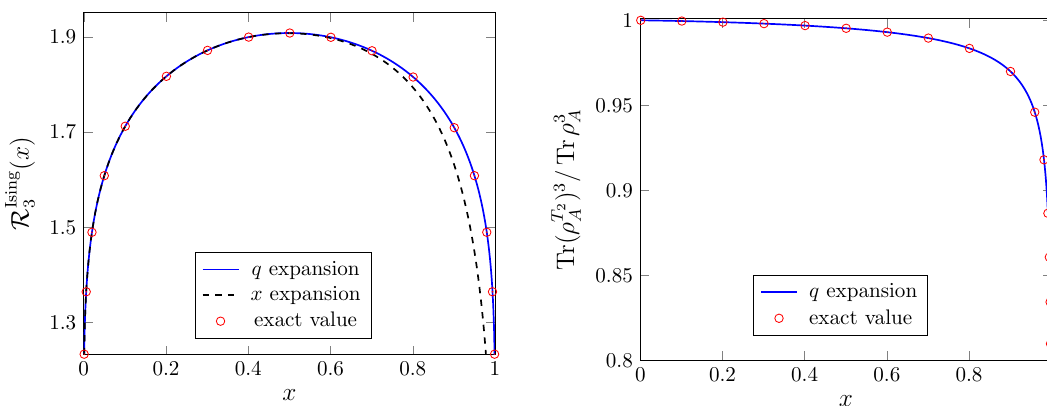
and Tr ( ρ T 2 ) N for N = 3 in the free Majorana fermion Figure 2 . Analysis of the moments Tr ρ N A A (Ising CFT). In the left panel, we consider the function R ( x ) defined in eq. (5.14). The dots 3 correspond to the exact values calculated using eq. (E.7). The continuous line has been obtained by approximating, in eq. (5.14), Tr ρ 3 with its expansion in sphere conformal blocks, see eq. (5.6) A and appendix E, truncated at level L = 6 . The dashed curve has been determined instead by decomposing Tr ρ 3 in terms of N = 3 orbifold conformal blocks, see eqs. (5.1) and (E.1), and A approximating these functions with their power series about x = 0 in eq. (3.29) up to L = 6 . In the right panel, we study the ratio Tr ( ρ T 2 ) 3 / Tr ρ 3 . The dots are the exact values computed from A A eqs. (5.14) and (5.15) by substituting eq. (E.7) for the function R . The continuous line is the result 3 if we approximate Tr ρ 3 and Tr ( ρ T 2 ) 3 with their expansions in terms of sphere conformal blocks up A A to level L = 6 . In all the cases, the sphere conformal blocks have been calculated using the elliptic recursion of eq. (4.6), truncated at level L 0 = 8